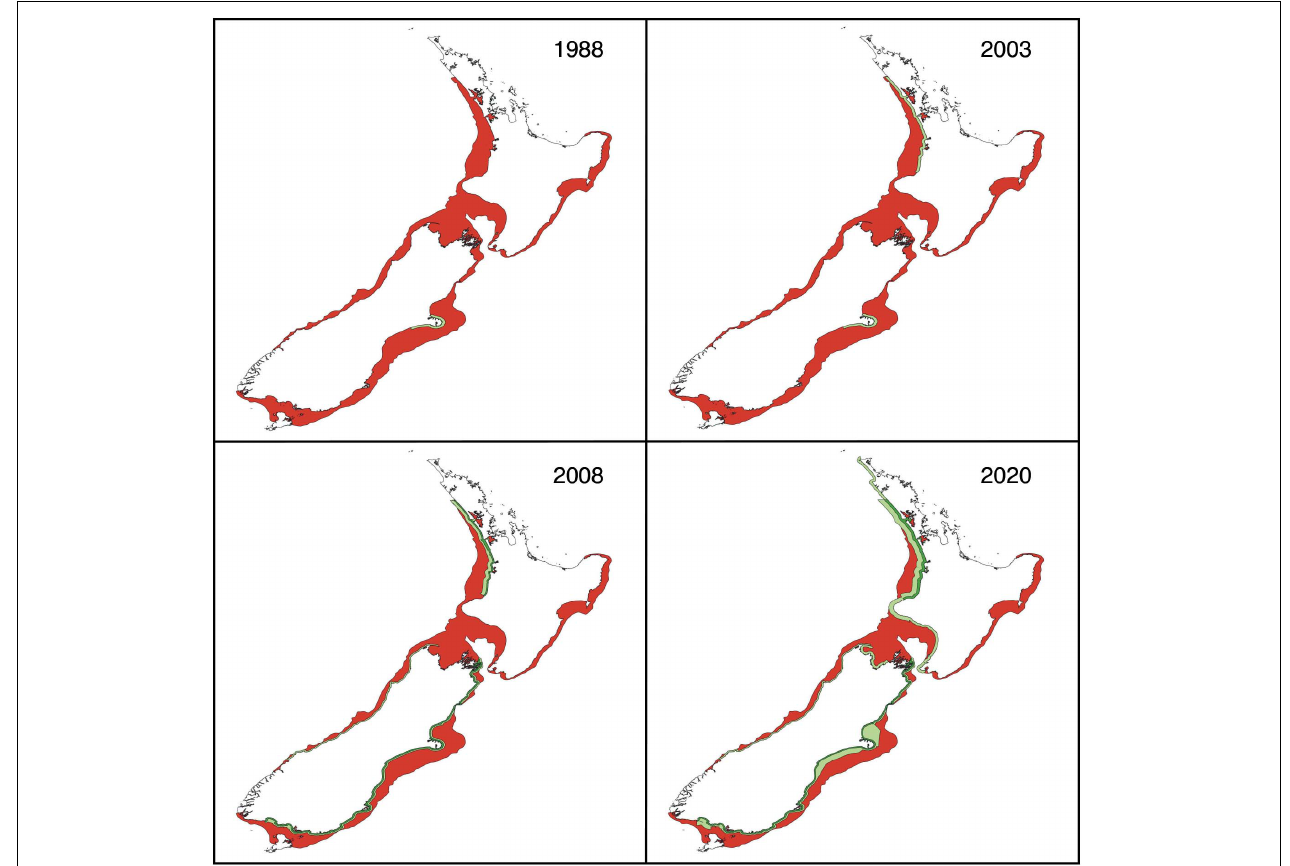
FIGURE 2 | Historical sequence of protection. Hector’s and M¯aui dolphin habitat is indicated in red, protection from gillnet and trawl fisheries in dark green, and protection from gillnet fisheries only in light